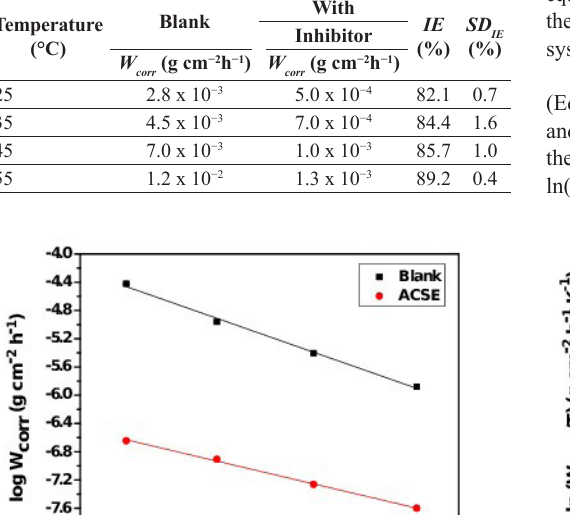
vs. 1/ T ); (B) (log( W / T ) vs. 1/ T ) for the mild steel corrosion in the absence and presence of ACSE. corr corr